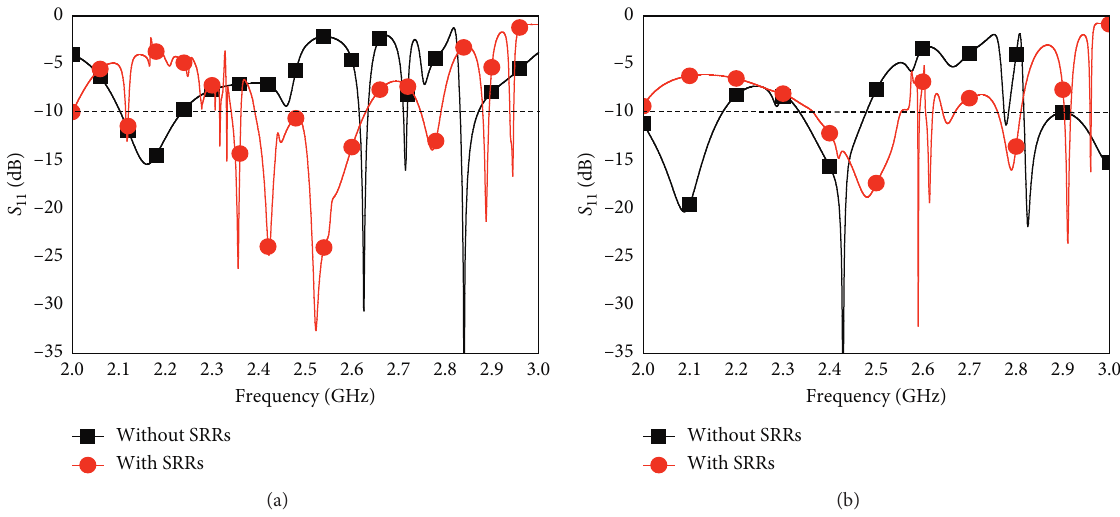
Figure 13: Comparison of S11 of the array (0.34 λ